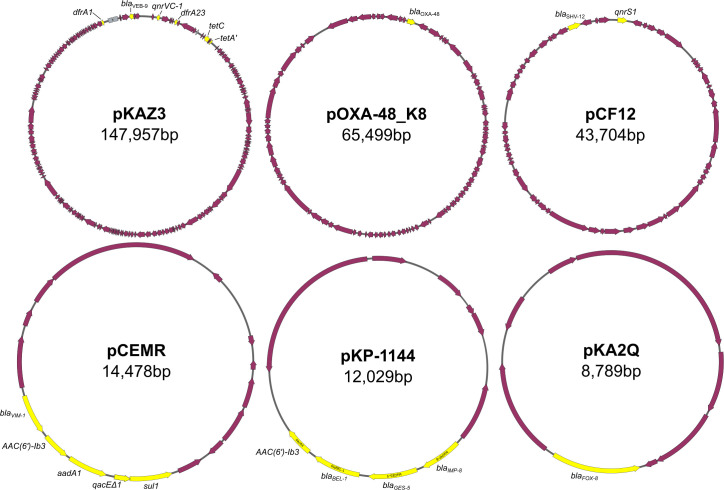
Plasmids used in this study.Scheme depicting the six plasmids used in this study. Antibiotic resistance genes are labeled and highlighted in yellow. Accession numbers are as follows: pKAZ3 (MT720905), pOXA-48_K8 (MT441554), pCF12 (MT720906), pCEMR (MT720903), pKP-1144 (MT720902), pKA2Q (MT720904). pOXA-48_K8 is a pOXA-48-like plasmid that shares a 100% coverage and >99% identity with the first described pOXA-48 plasmid (Poirel et al., 2012). For simplicity, we refer to this plasmid as pOXA-48 throughout the text. Plasmids are not drawn to scale.